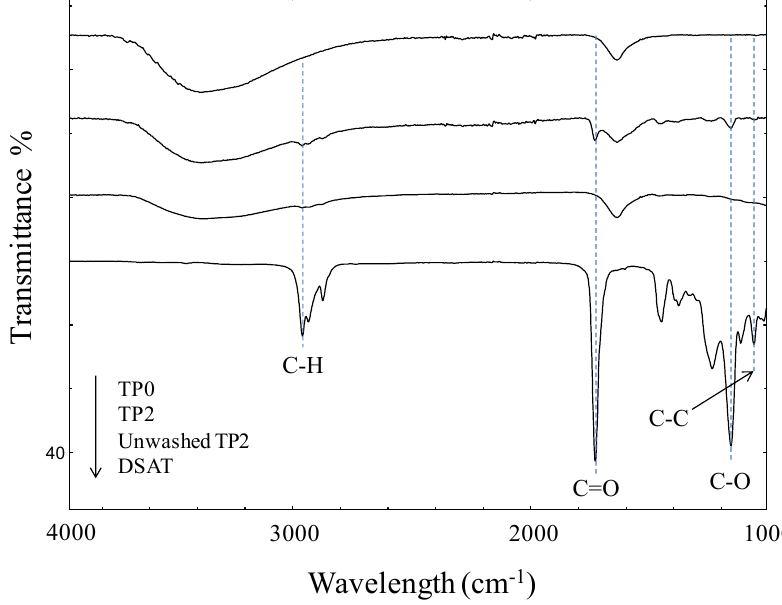
Figure 5. FTIR spectra of TP0, TP2 (washed TP2), unwashed TP2 and double-sided adhesive tape (DSAT) samples.